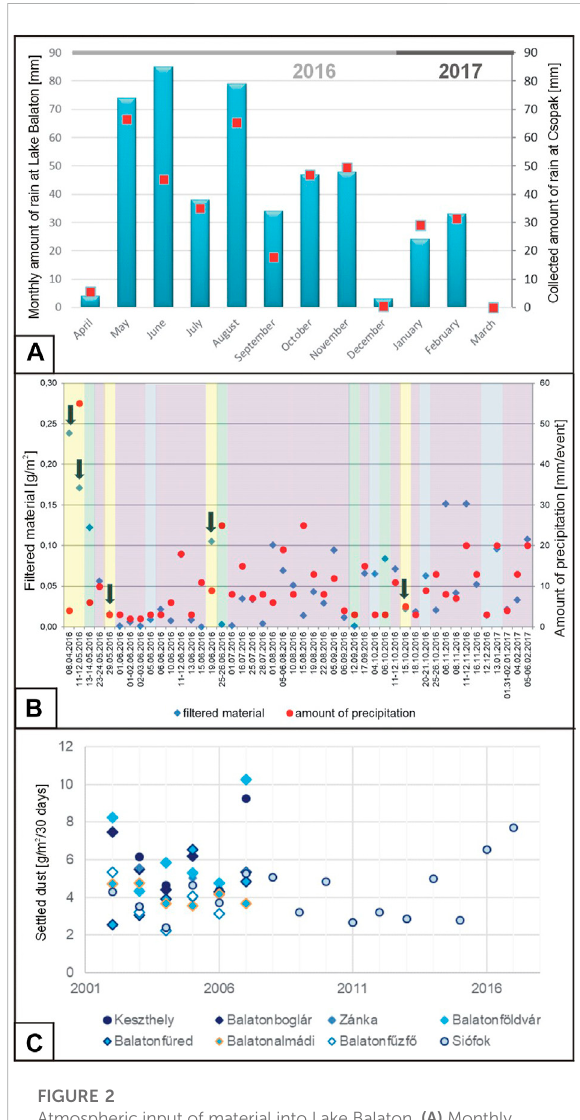
FIGURE 2 Atmospheric input of material into Lake Balaton. (A) Monthly amount of rain in the area of Lake Balaton from 08 April 2016 to 31 March 2017, based on daily meteorological reports by the Hungarian Meteorological Survey (HMS) (blue columns), and monthly amount of rainwater collected in Csopak over the same period (red squares). (B) Amount of solid material fi ltered from rainwater (g/m 2 ), and daily amount of rain (mm/event), based on daily meteorological reports of HMS. The background colors indicate the origins of air masses: yellow for South, green for East, blue for North, and pink for West. Black arrows indicate Saharan dust events (08 April 2016, 11 – 12 May 2016, 29 May 2016, 19 June 2016, 15October 2016). (C) Average amount ofsettled dust (g/m 2 / 30 days) based on data published by the Hungarian Air Quality Network. (An outlier data point of settled dust in Keszthely (18.41 g/m 2 /30 days in 2002) has been deleted and was not considered in our calculations, since it was probably in fl uenced by a local